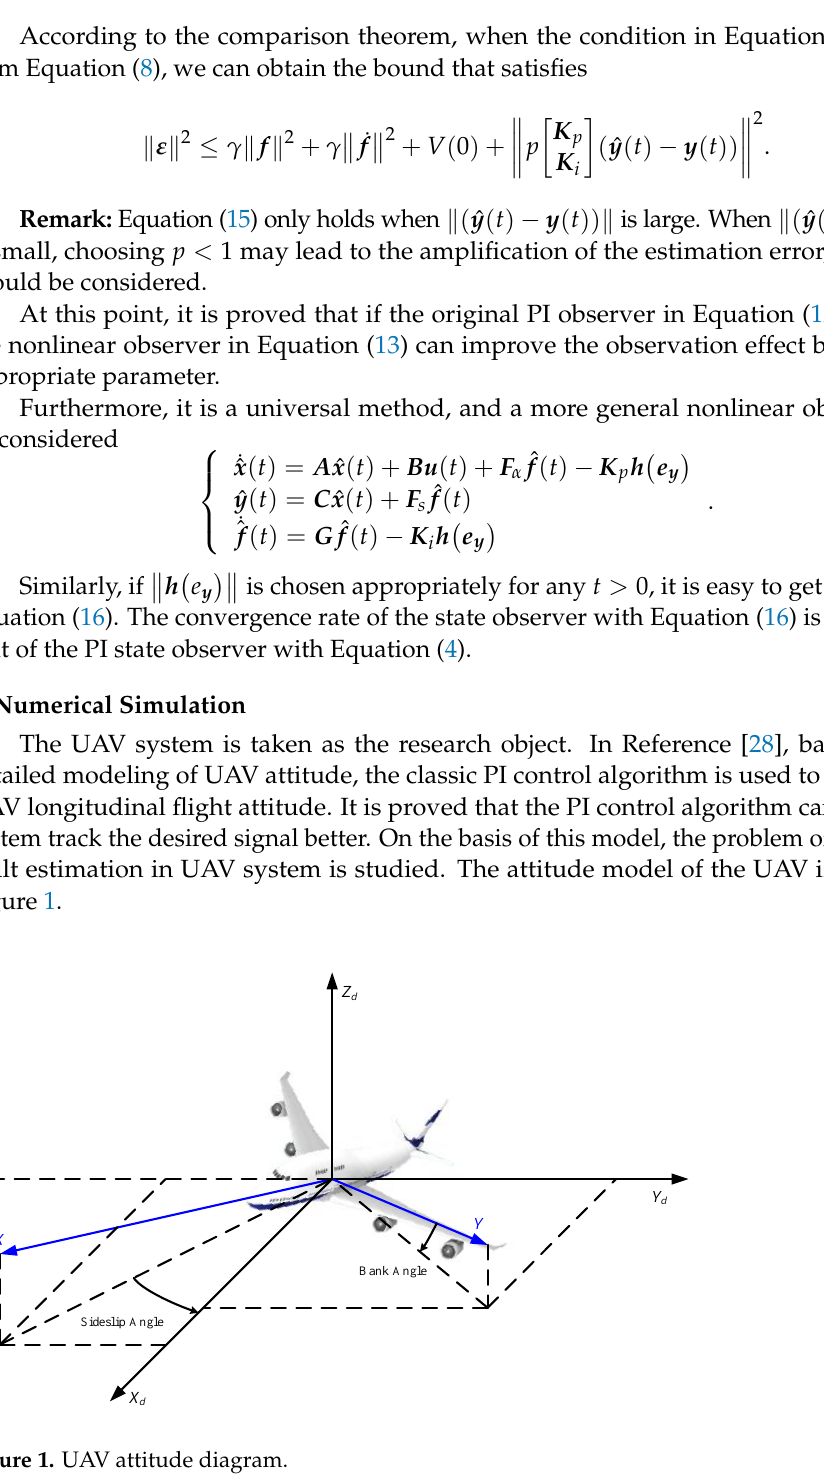
Figure 1. UAV attitude